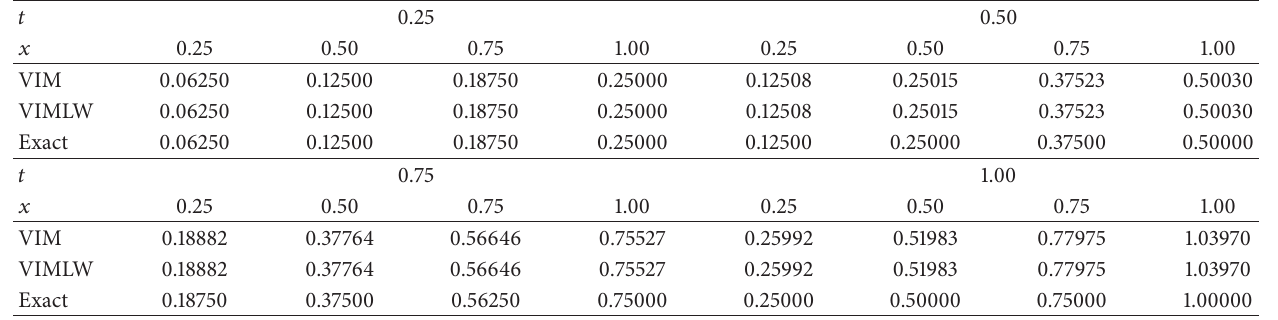
Table 3: Numerical values when 𝑡 = 0.25 , 0.50, 0.75, and 1.0 for (56).